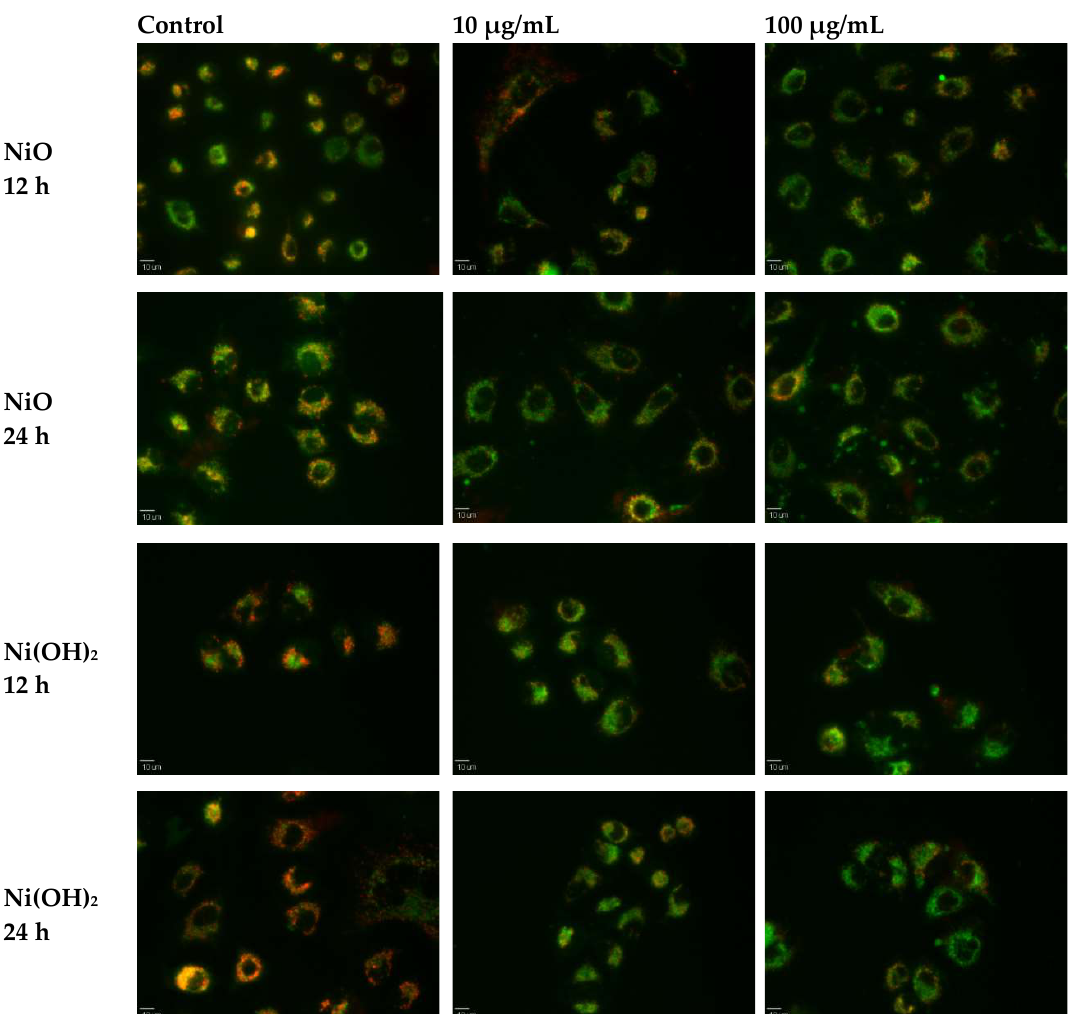
Figure 6. Fluorescence microscopy images of mitochondria membrane potential (MMP) after exposure to NiO or Ni(OH) 2 for 12 or 24 h. Scale bars are 10 μm.